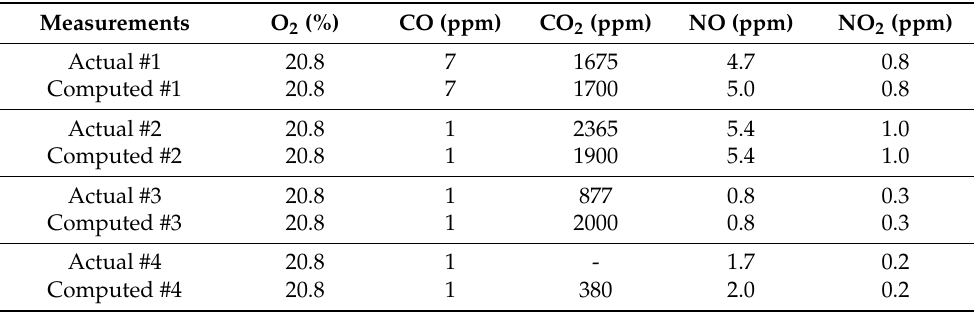
Table 4. Comparison between real data air quality measurements and corresponding software results at selected points in the mine.